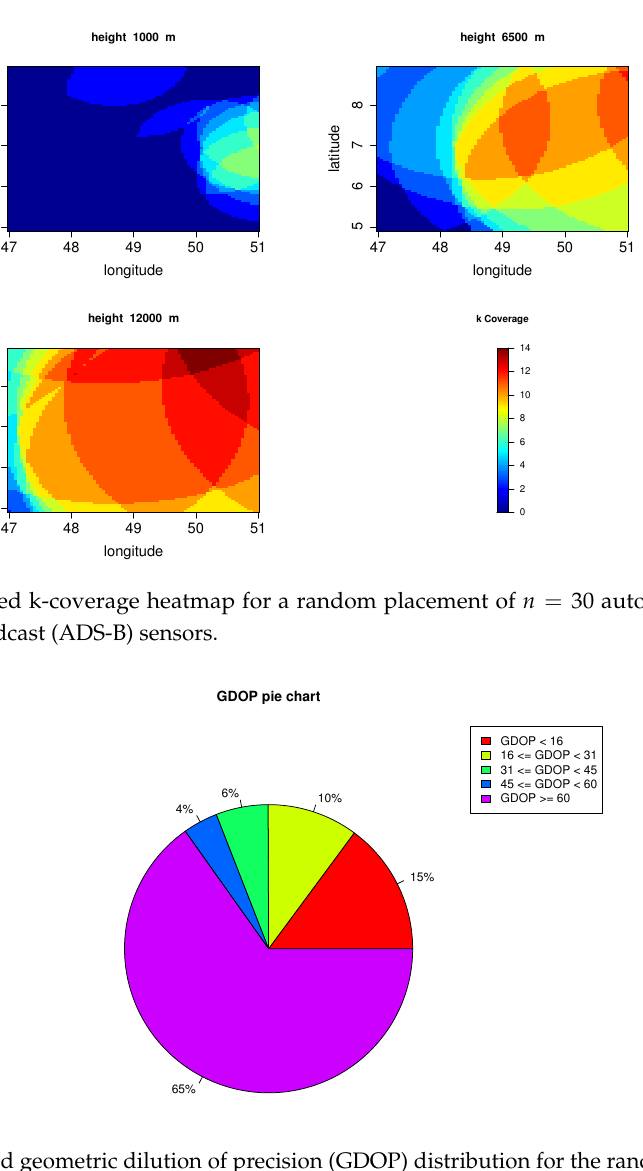
Figure 2. Simulated geometric dilution of precision (GDOP) distribution for the random placement of n = 30 ADS-B sensors. The corresponding k coverage heatmap is given in Figure